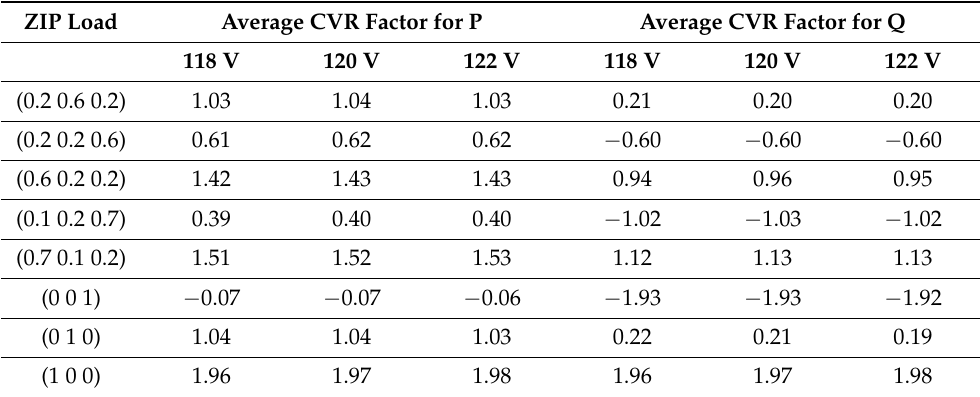
Table 2. Average CVR factor obtained using power captured at